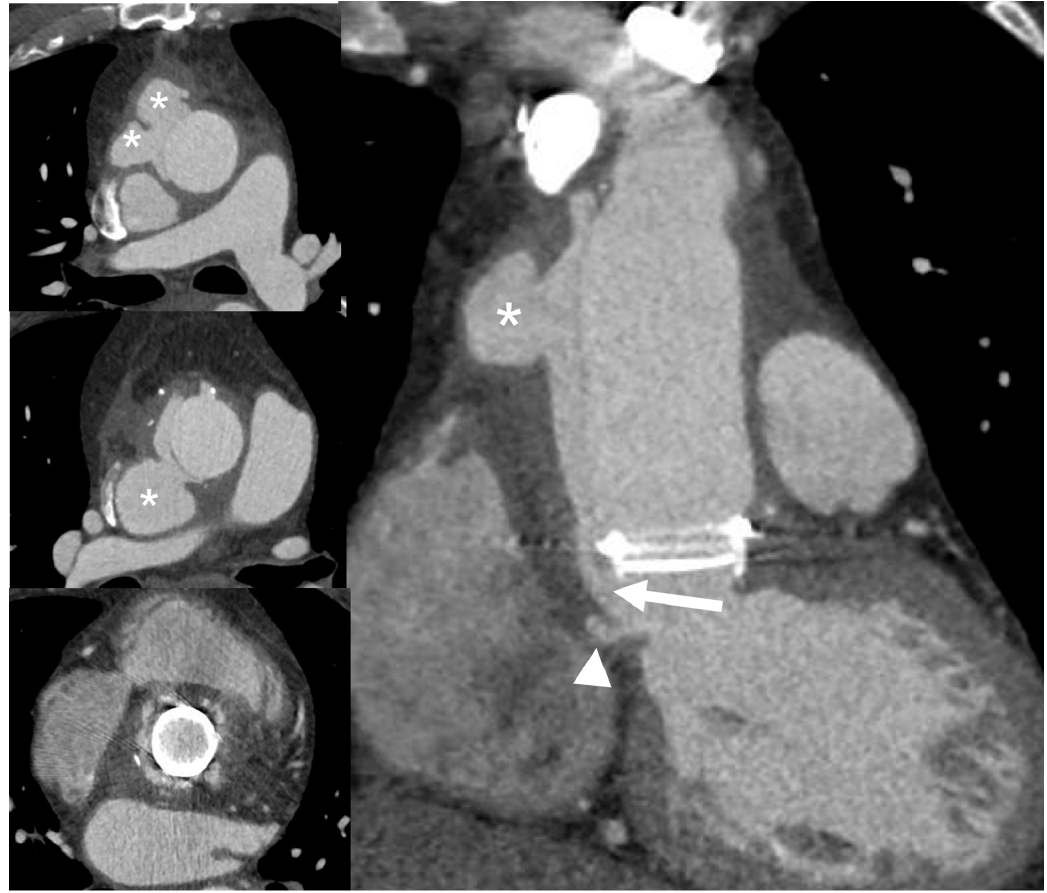
Figure 6. Infective late complication in a patient with Bentall prosthesis: Dehiscence and periprosthetic pseudoaneurysm . CCTA multiplanar reconstructions show a large dehiscence of the surgical suture at the proximal anastomosis of the prosthesis with large communication (arrow) of the left ventricular cavity with a large false lumen (asterisks) recanalized from perivalvular communication (arrow); a little periannular pseudoaneurysm (arrowhead) is seen adjacent to the ventriculo-aortic junction.